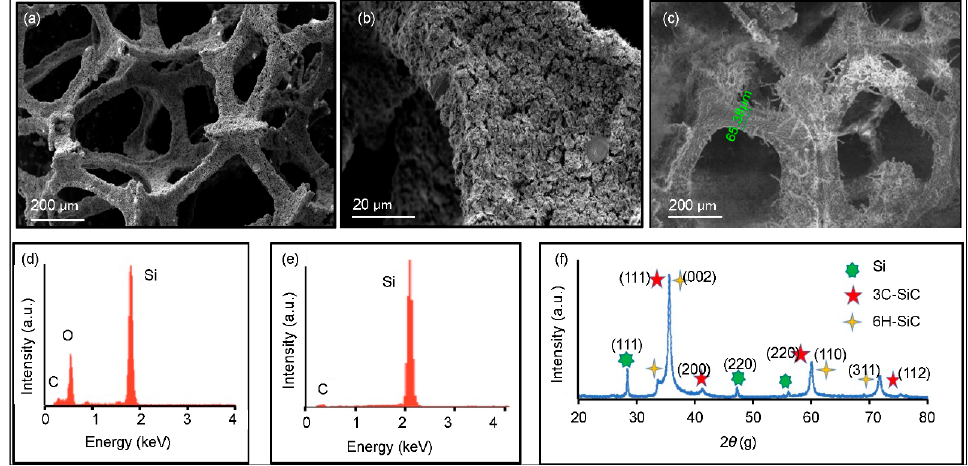
Figure 2. Morphological and elemental characterization of the grown foam: ( a – c ) SEM images; ( d , e ) EDS data taken before and after an HF etch; ( f ) XRD pattern of the HF-etched foam with hkl